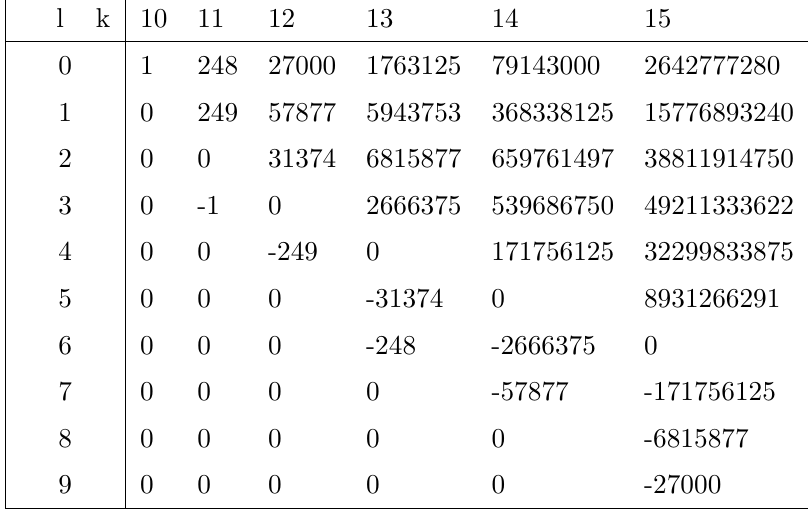
for one E 8 k;l